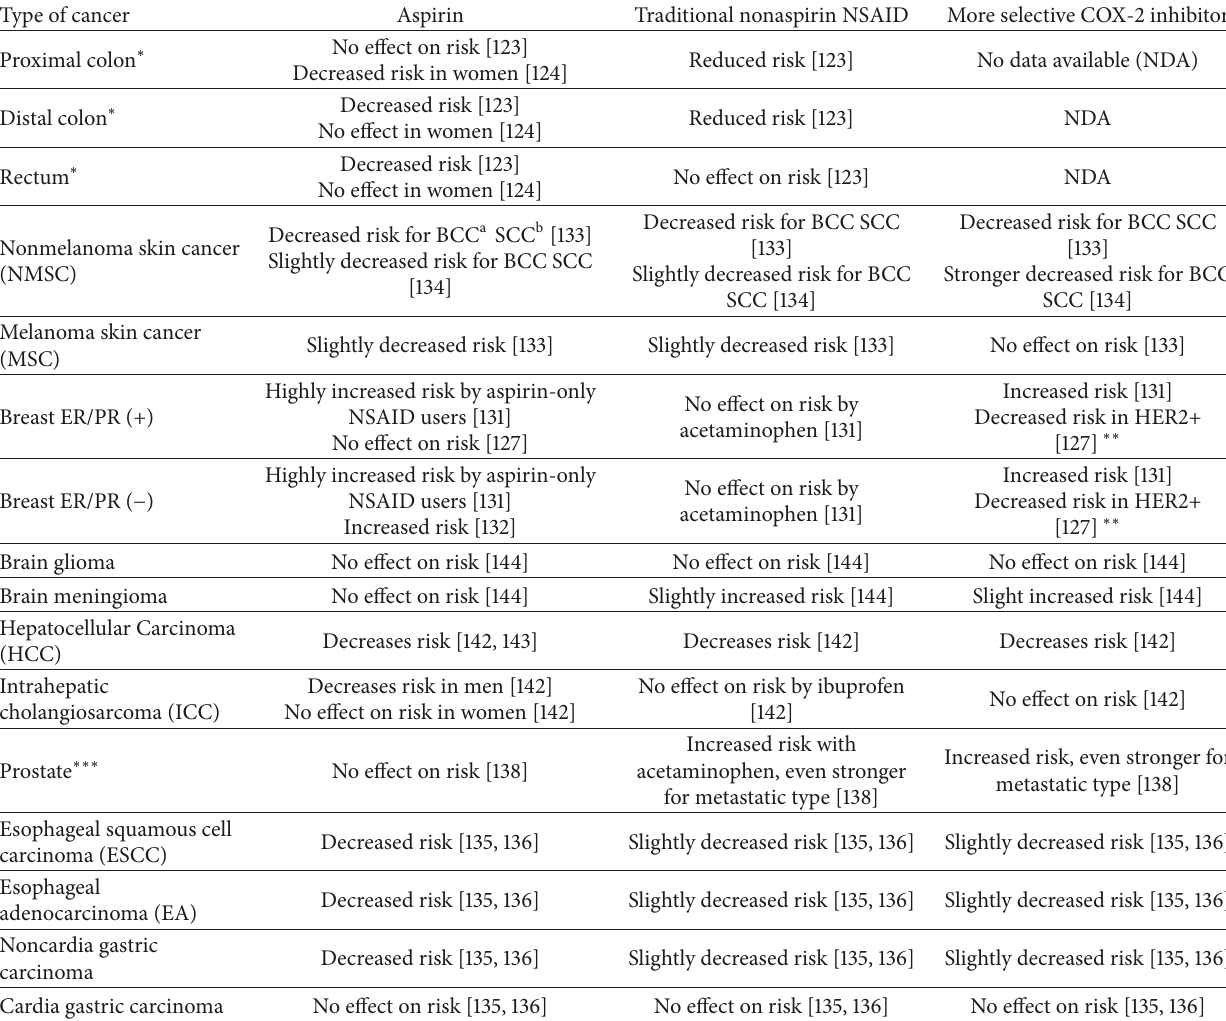
Table 1: Cancer risk development from NSAID use as recorded from various epidemiology